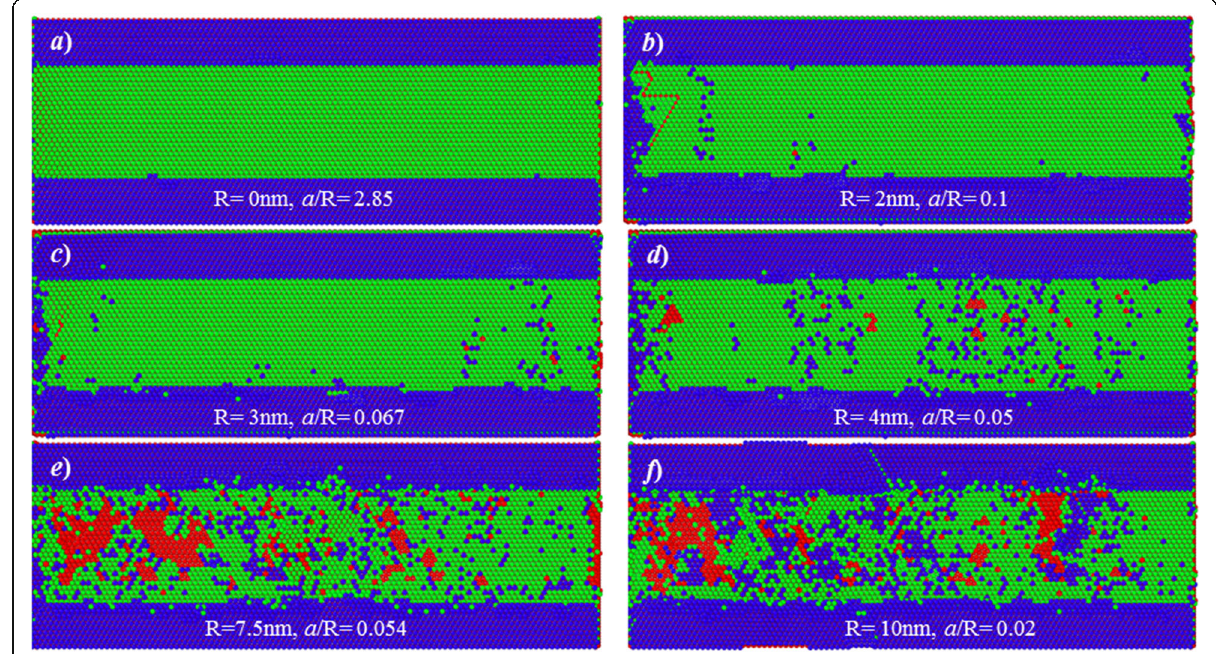
Fig. 7 Surface composition of processed surfaces. Atoms are coloured based on the number of atomic